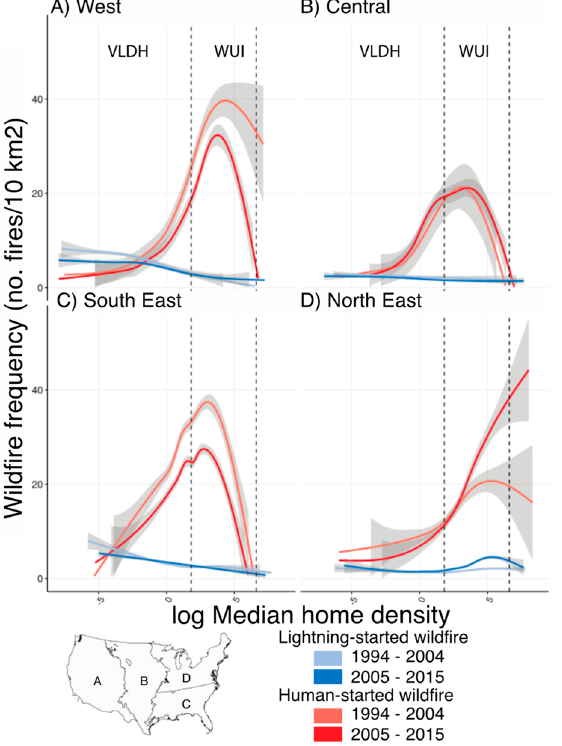
Figure 5. Regional relationships between human- and lightning-caused wildfire ignition frequency and the log median home density within 10-km pixel between two decades (1994–2004 and 2005–2015). Solid lines are based on the best fit Generalized Additive Model regressions with 95th confidence envelope. Dotted vertical lines indicate the division between the WUI and VLDH categories, assuming constant vegetation cover, where urban / WUI boundary equals log(741.3162) home density and the WUI / VLDH boundary equals log(6.17) home density.